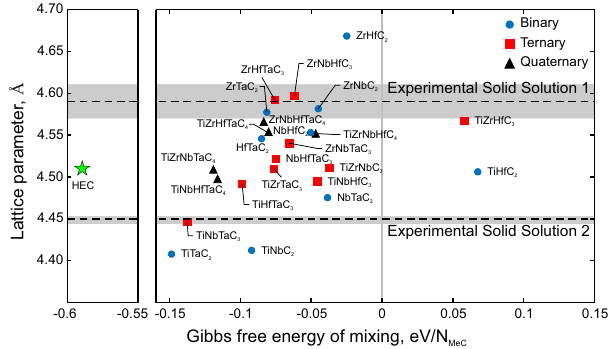
Fig. 4 Correlation between the Gibbs free energy of mixing calculated at 500 K and the lattice parameters of binary (circles), ternary (squares), quaternary (triangles) carbides, and HEC (star). Horizontal dashed lines and shaded areas represent lattice para- meters and error of the experimentally observed phases respectively.